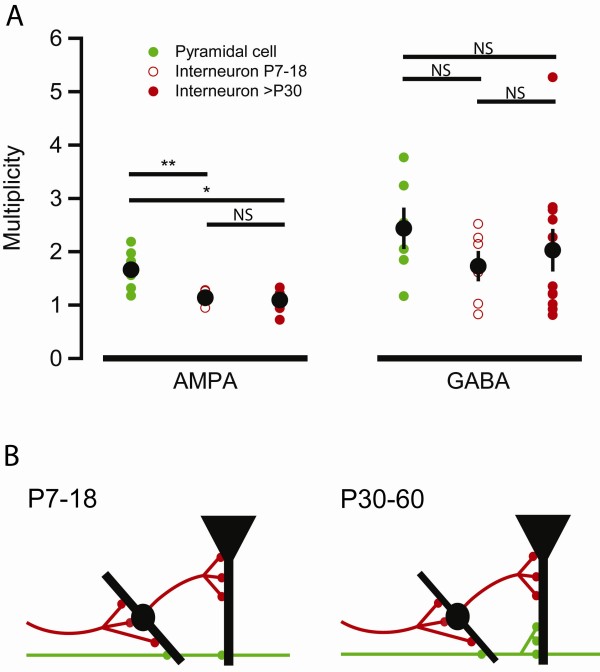
Summary and schematic model. (A) Summary of the multiplicity data obtained in Figures 1-3. ANOVA and Bonferroni post hoc test shows a significant difference between AMPA multiplicity in pyramidal cells from young adult animals and AMPA multiplicity in interneurons of both P7-18 rats and young adult rats (P = 0.004 and P = 0.02, respectively, left panel), but no significant differences between the groups of the right panel. (B) Schematic model illustrating the development of connectivity onto pyramidal cells and interneurons in stratum radiatum. Inhibitory (red) axons form multiple connections already in the P7-18 rats, whereas the excitatory (green) axons start out with single release site connections (left panel). During development excitatory axons grow multi release site connections onto pyramidal cells, but not to interneurons in stratum radiatum (right panel).